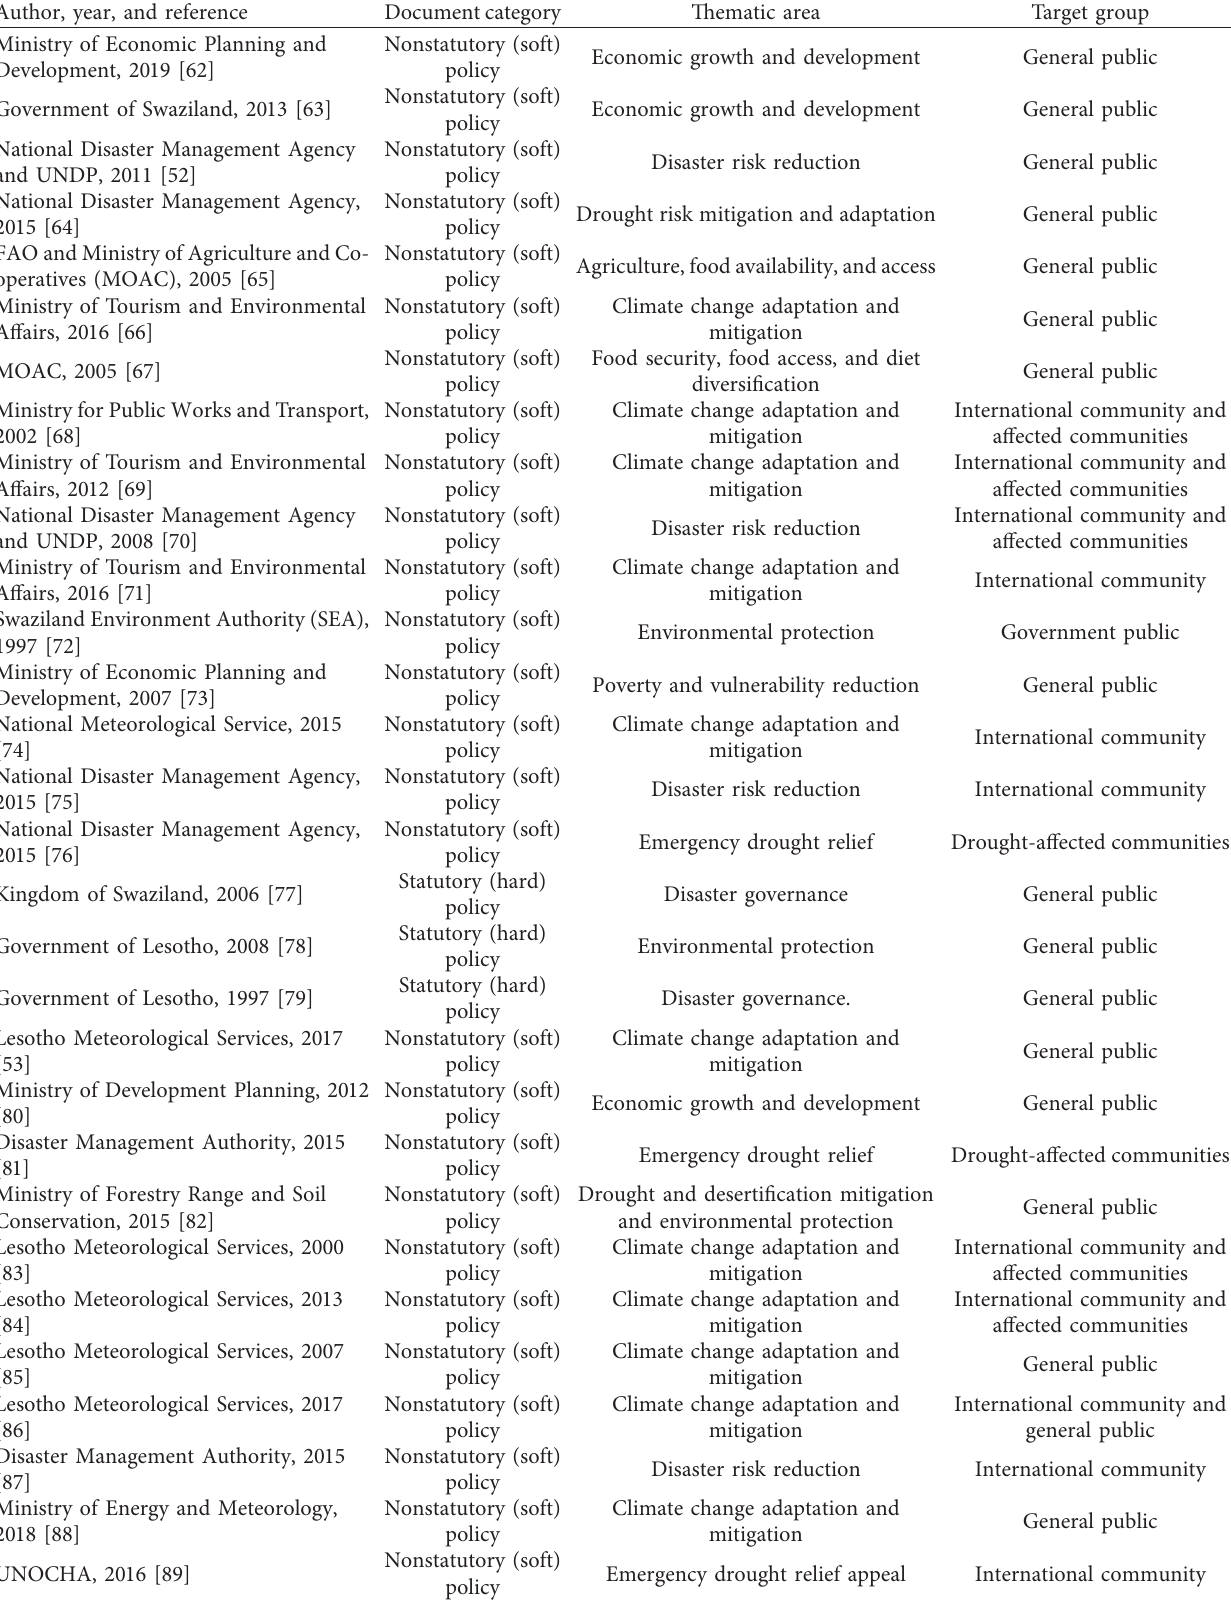
Table 3: Included policy category, focus, and target in Eswatini and